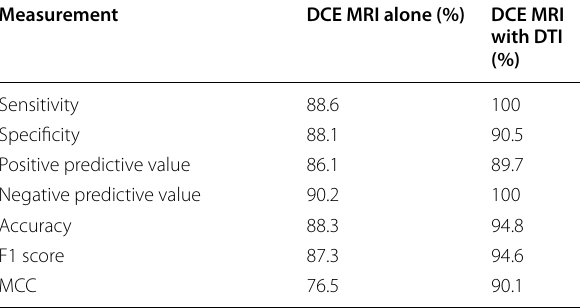
Accuracy (TP TN) / (all Positive = + MCC Matthews Correlation Coefficient = *(TP FN) *(TN FP) *(TN + +